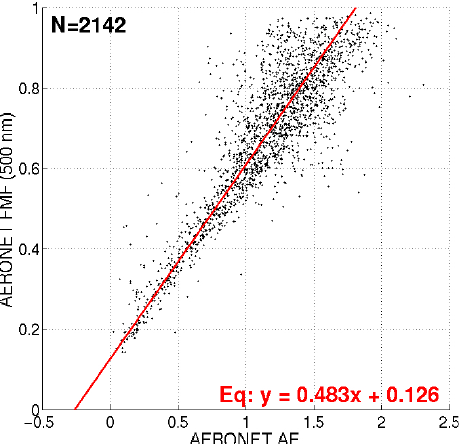
Fig. 6. Comparing monthly AERONET fine mode fraction (FMF) at 500nm to monthly AERONET ˚Angstr¨om exponent (AE). The red line represents our best linear fit. The fitting equation (Eq) and the number of data points ( N ) are given in the plot.